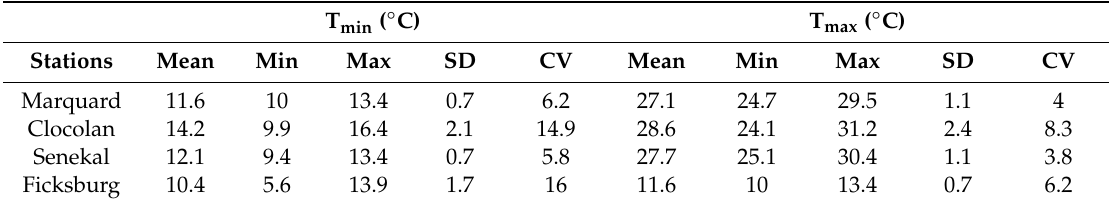
Table 2. The mean, minimum, maximum, SD and CV (%), for the minimum and maximum temperatures during the growing period ( ◦ C) in the Setsoto Municipality for the period between 1985 to